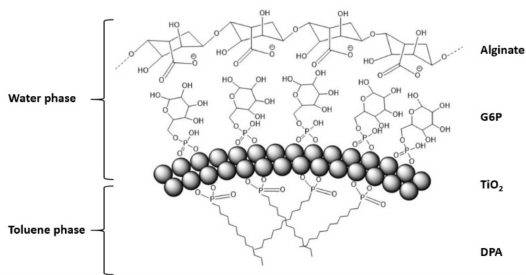
Figure 4. Proposed structure of self-assembled nanoshells. The inner side of the spheres are coated with the hydrophobic ligand (DPA), facing encapsulated toluene, and the outer side is coated with the hydrophilic ligand (G6P), facing the water phase. The alginate polymer helps stabilizing the nanoshells and may interact with the hydrophilic ligand via hydrogen bonding, and potentially via electrostatic interaction with the titania